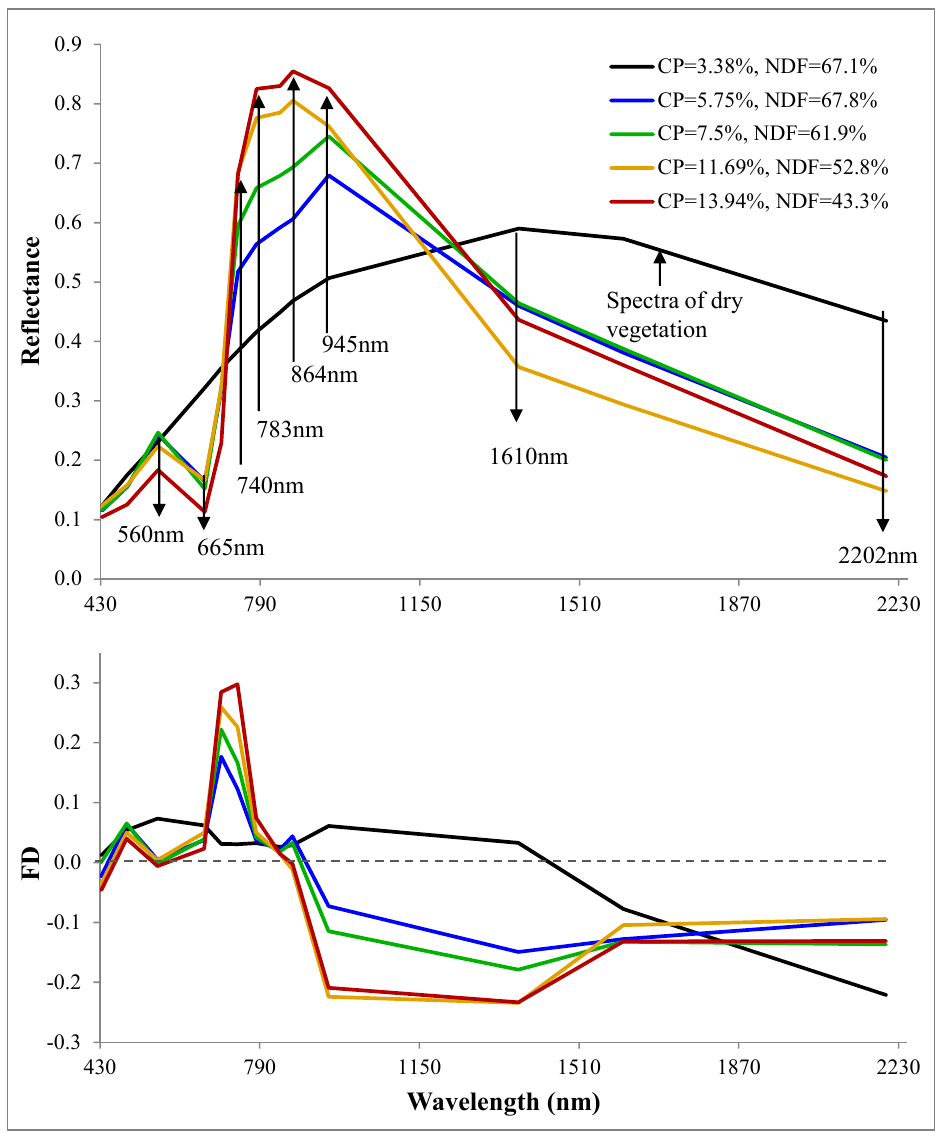
Figure 4. Reflectance (upper) and First Derivative (FD) (lower) spectra of five vegetation samples (laboratory data set) with different percentages of CP and NDF. Note the variability in reflectance and FD across the spectral bands, with associated changes in CP and NDF concentration. Specifically, as reflectance increases at 740 nm, 783 nm, 865 nm, and 945 nm, CP values rise and NDF values fall; and as reflectance decreases at 560nm, 665nm, 1610 nm, and 2202 nm, CP values fall and NDF values